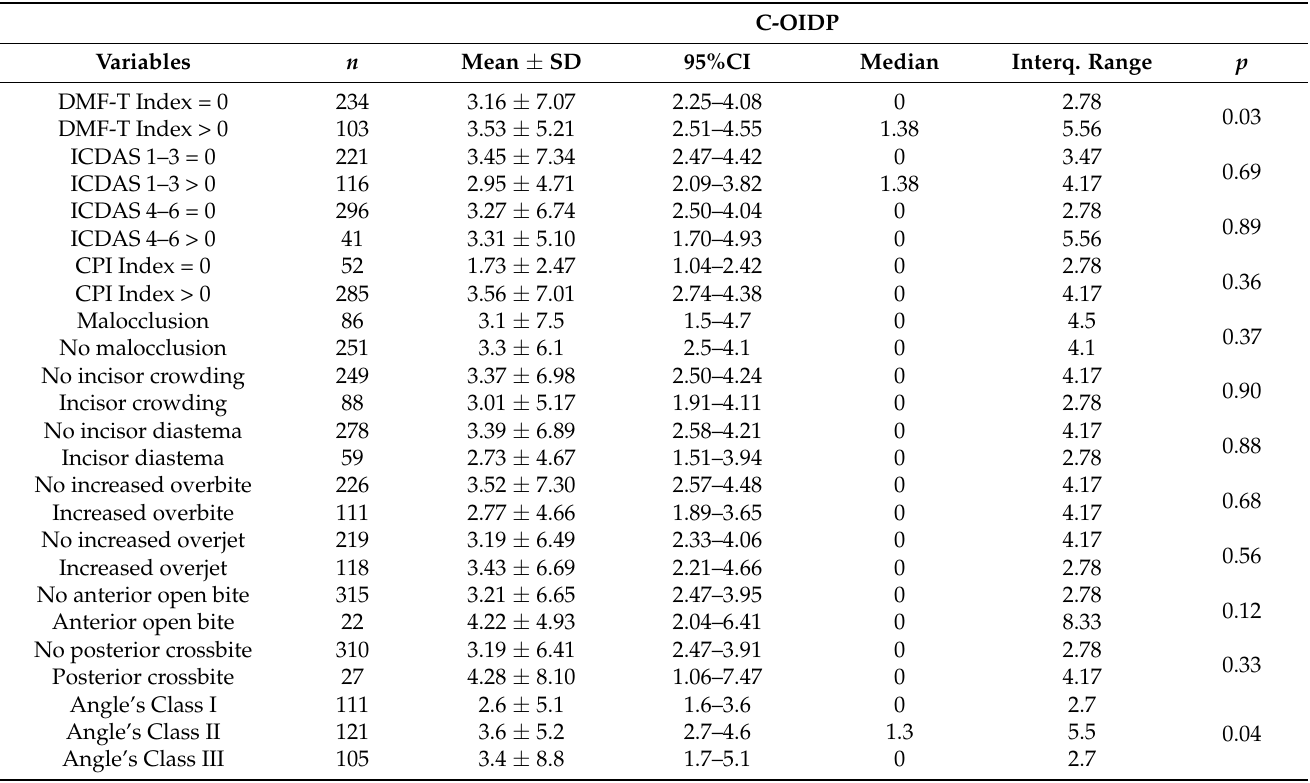
Table 6. Association between clinical variables and C-OIDP